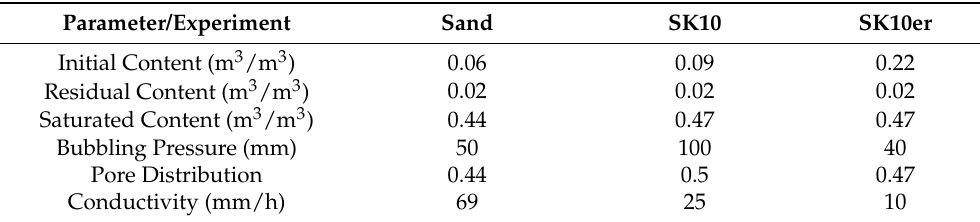
Table 8. Calibrated values of parameters for different experiments using the Smith Parlange method. Initial values are shown in Table 3.